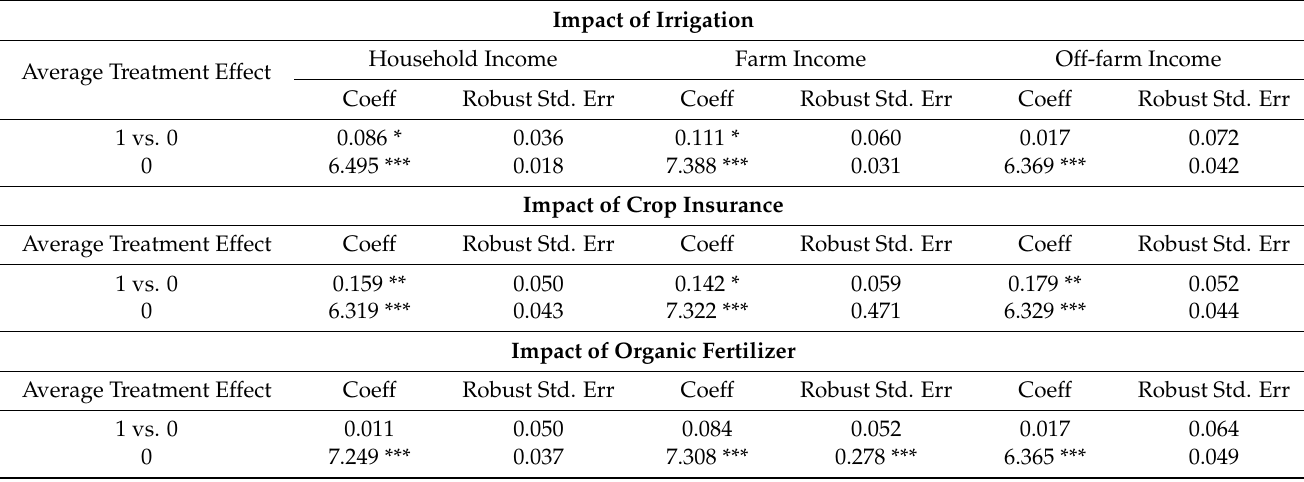
Table 9. Telasso average treatment effect of climate-smart agricultural practices on farmers’ income. Impact of